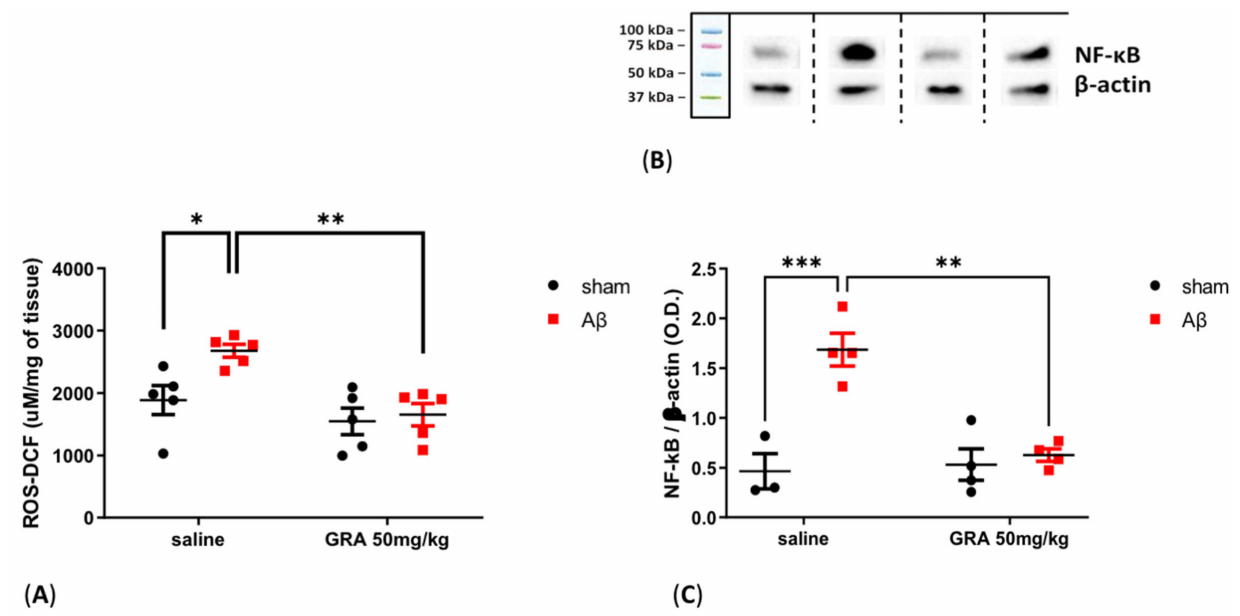
Figure 6. Effect of GRA administration on cortical ROS measurement and NF-kB protein expression levels in sA β -1-42-treated rats. Effect of GRA (50 mg/kg) administration on cortical ROS content (( A ), n = 5 per group), NF-kB (( C ), saline sham n = 3, saline sA β 1-42 n = 4, GRA sham n = 4 and GRA sA β 1-42 n = 4) in rats 7 days after i.c.v. injection of vehicle (sham, 5 µ L, black dots) or A β (A β , 4 µ M, red dots). ( B ). Representative images of Western blotting bands of NF-kB and β -actin housekeeping gene in the prefrontal cortex of saline sham, saline sA β 1-42, GRA sham and GRA sA β 1-42 -treated animals. *** p < 0.001, * p < 0.05 saline sA β 1-42 vs. saline sham; ** p < 0.01 GRA sA β 1-42 vs. saline sA β 1-42. Two-way ANOVA followed by Bonferroni’s post hoc